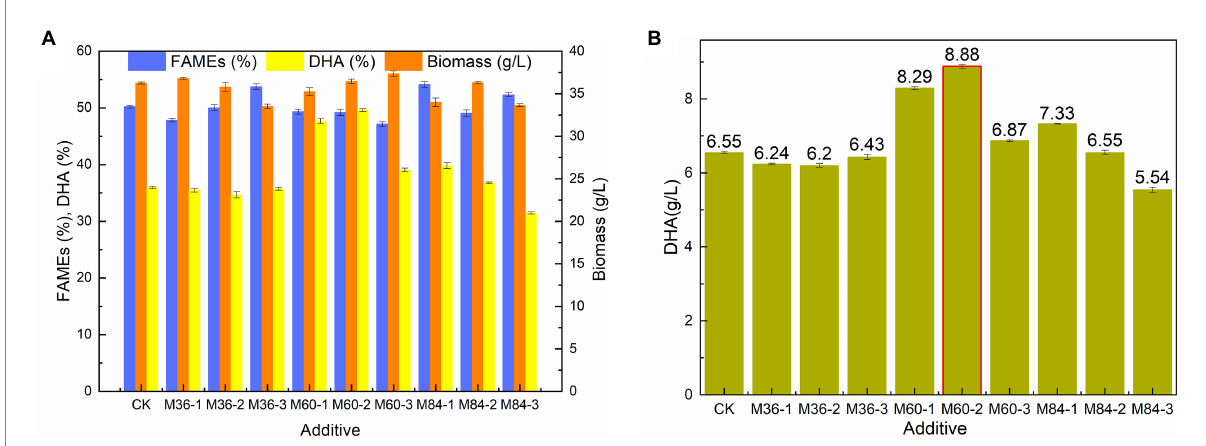
FIGURE 1 Comparison of biomass, FAME, DHA content, and DHA yield by Schizochytrium sp. FJU-512 shaking cultivated under different malate conditions. Each point is the mean ± SD of three independent experimental replicates. Error bars represent the standard error of means. CK: control group (no malate added); M36, M60, M84: malate added at 36, 60, and 84 h, respectively; − 1, − 2, − 3: 1 g/l, 3 g/l, and 5 g/l of malate, respectively. (A) Biomass, FAME (%), and DHA (%) with respect to malate addition and time points. (B) DHA (g/L) with respect to malate addition and time